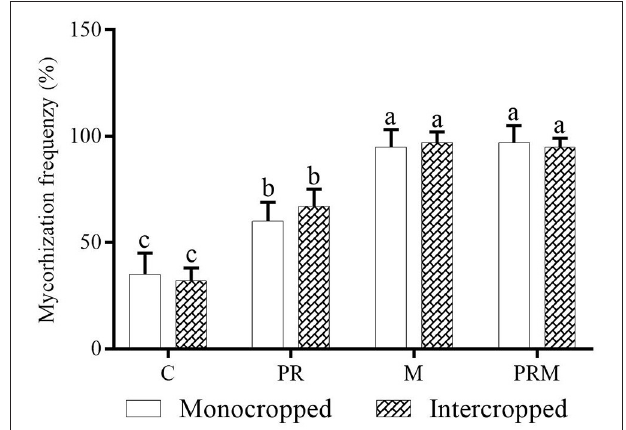
FIGURE 1 | Effect of the intercropping system and inoculation with rhizobacteria consortium (PR), mycorrhizae (M), and their combination